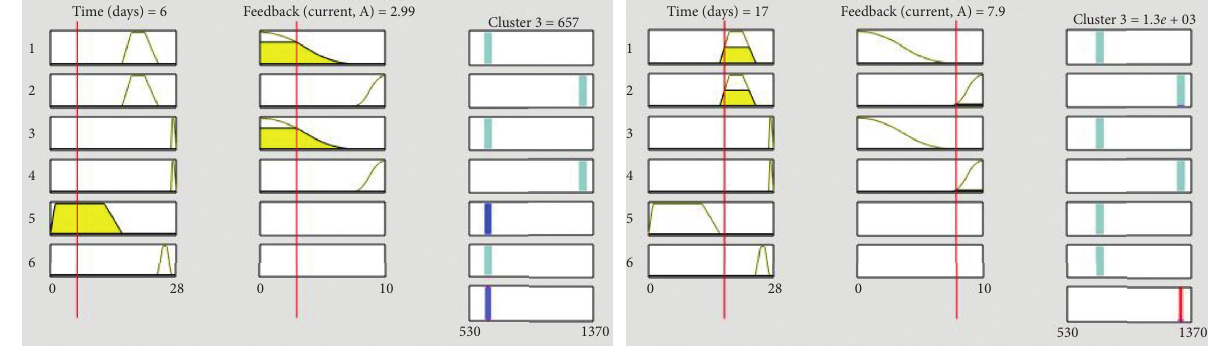
Figure 13: Output result representation of off-peak and peak points for cluster 3.